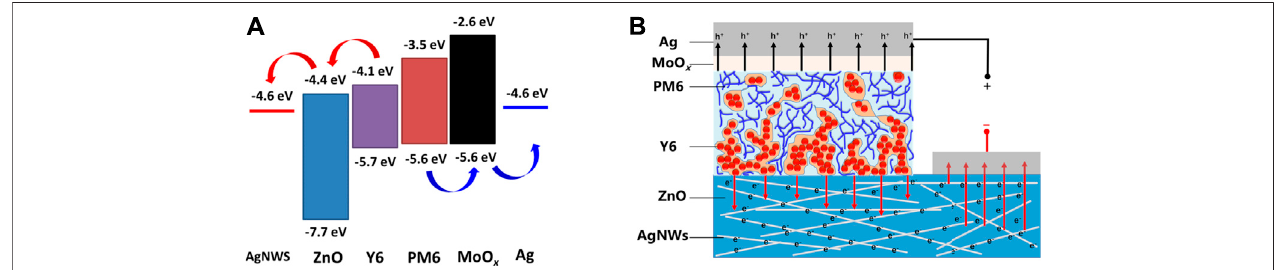
FIGURE 10 | Carrier transport analysis of an AgNWs/ZnO-based polymer solar cell. (A) Energy level (B) and carrier transport path diagram of an AgNWs/ZnO- based PM6:Y6 polymer solar